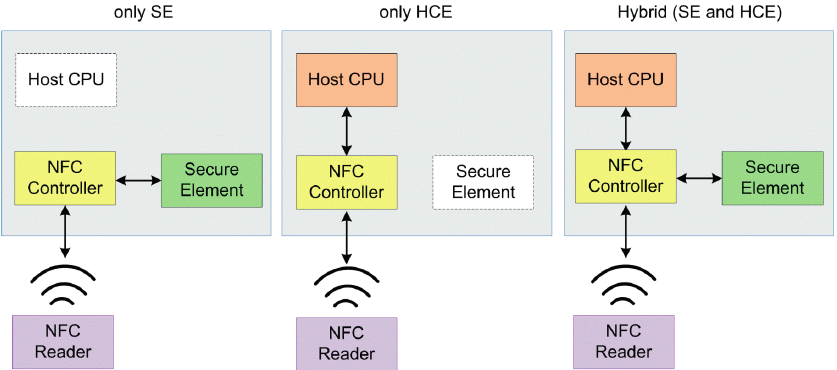
Figure 6. SE and HCE architecture